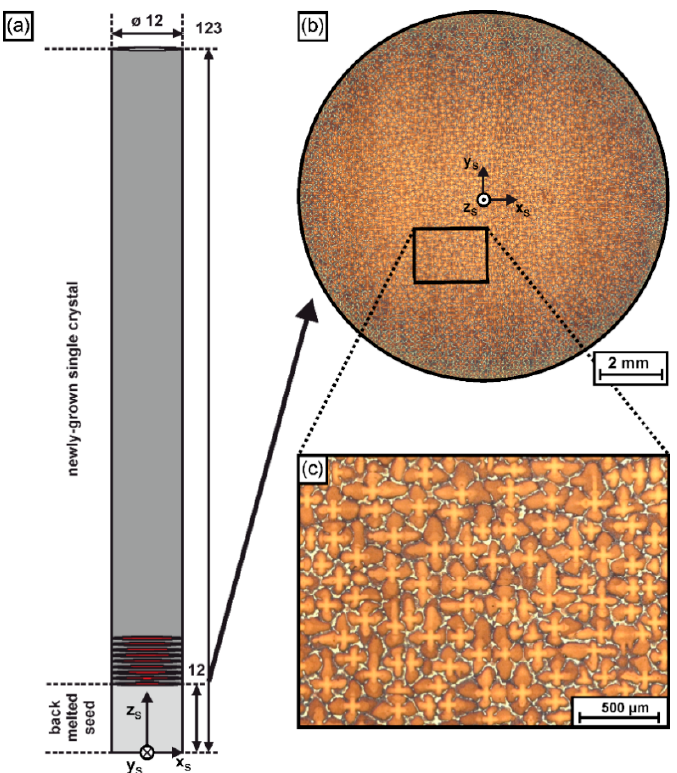
Figure 2. Serial sectioning of the cylindrical SX rods prepared by seeded Bridgman solidification. ( a ) Geometry, coordinate system and positions of cross-sectional planes (red color). ( b ) Example for dendritic microstructures (here: first sample slice of the newly-grown single crystal). ( c ) Microstruc- ture from black rectangular field at higher magnification.